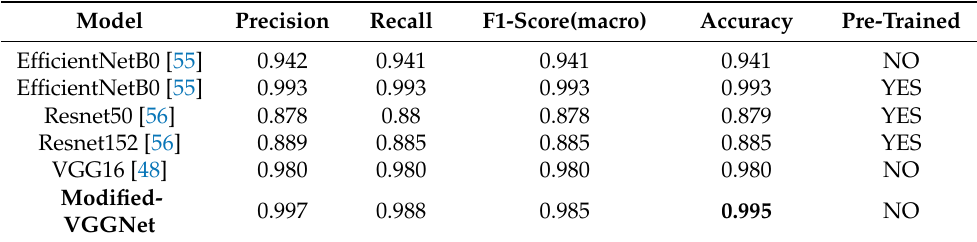
Table 6. Comparison of the proposed structure with existing popular architectures.